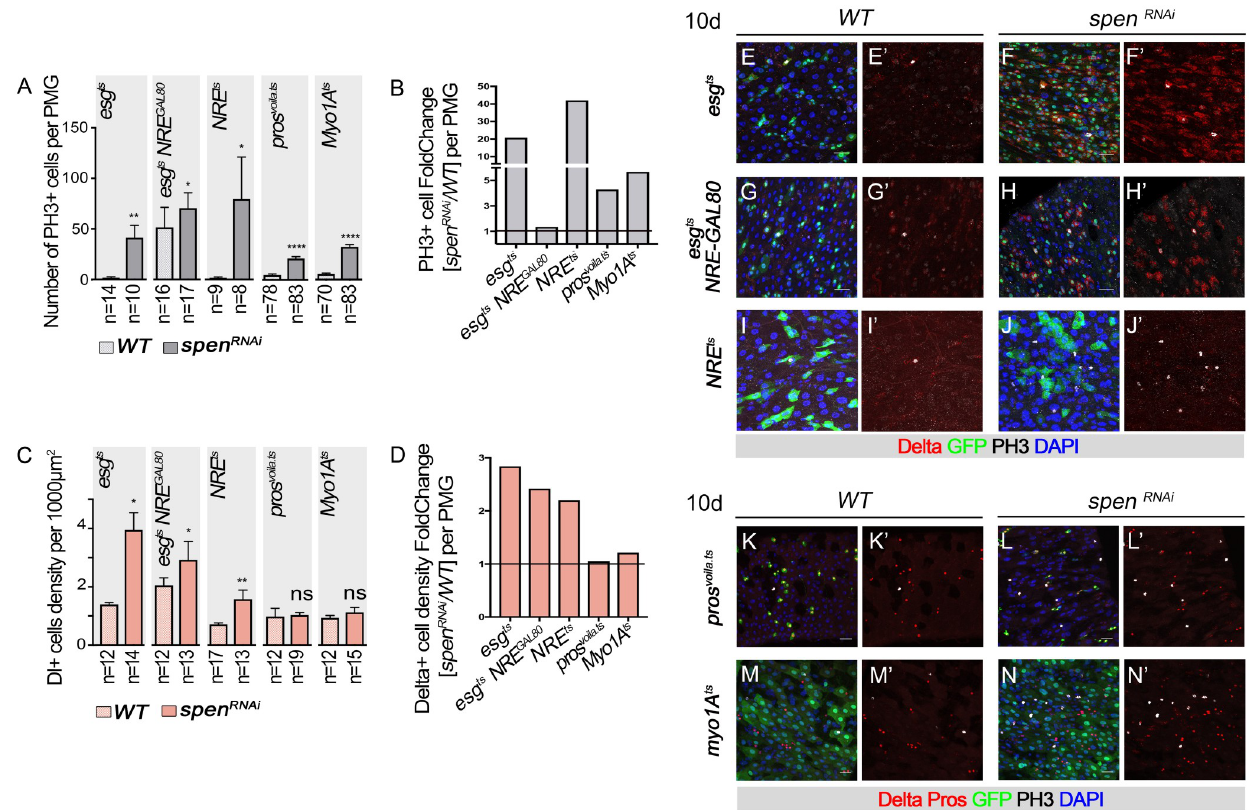
Fig 2. Spen has stem cell autonomous and non-autonomous functions to control ISC numbers and proliferation state. ( A-D) Quantification of E-N’ ( A ) the number of mitotic cell (PH3+ cells) or ( B ) relative increase in proportion per posterior midgut (PMG) in the indicated genotypes. (C) the density of Dl+ ISCs or (D) relative increase. (E, E’, G, G’, I, I’, K, K’, M, M’) wild-type UAS-GFP control and (F,F’, H, H’, J, J’,L, L’, N, N’) UAS-spen RNAi expressed for 10 days at 29˚C. An increased number of PH3+ cells and Dl+ ISCs was detected upon expression of UAS-spen RNAi in ISCs and EBs (E- F’) , ISCs only (G-H’) , and EBs only ( I- J’ ; using esg ts , esg ts combined with NRE-GAL80 – to block expression in Notch active EB cells, or NRE ts , respectively). ( K-N’ ) An increase in PH3+ cells was also found upon expression of UAS-spen RNAi in Enteroendocrine cells ( pros voila . ts ) or in Enterocytes using myo1A ts . GFP in GREEN marks cell type expression, Delta+ ISCs, RED, mitotic cells (PH3+, Gray), DNA (DAPI, BLUE). Scale bar: 20 μ m.